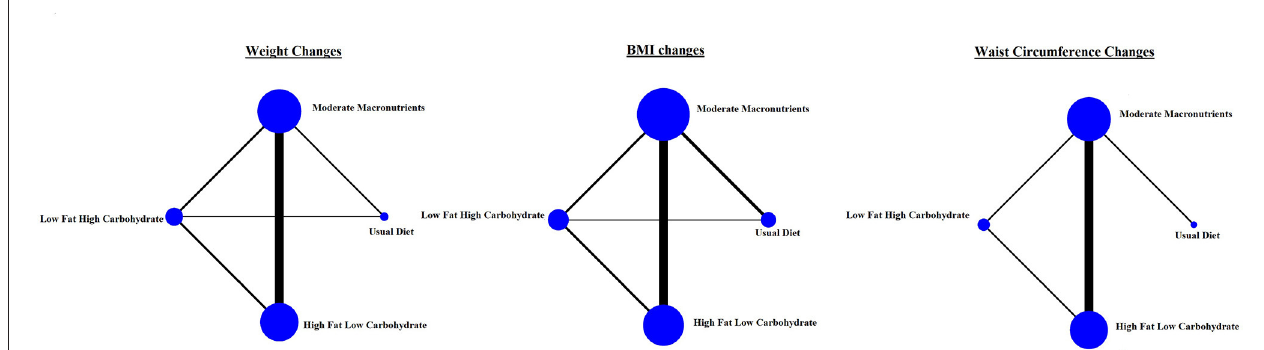
FIGURE 2 | Network plot of included studies.